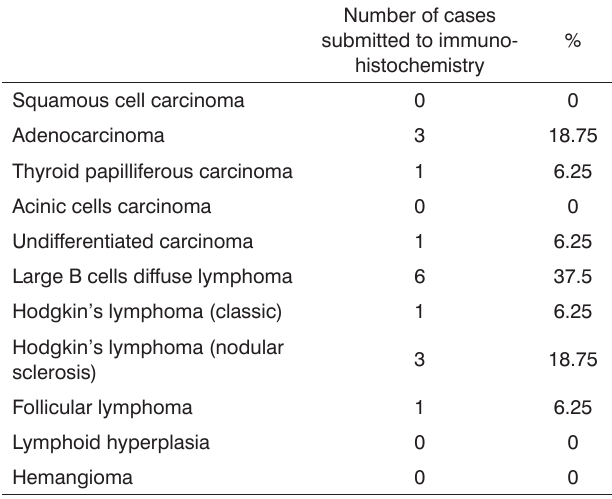
Table 3. Distribution of the number of cases submitted toimmunohistochemistry according to the histological cell line (n = 16).